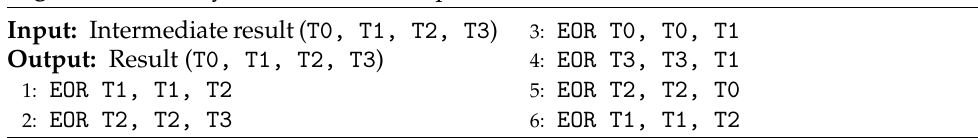
Algorithm 5 M 1 layer of ARIA block cipher on ARM Cortex-M3.